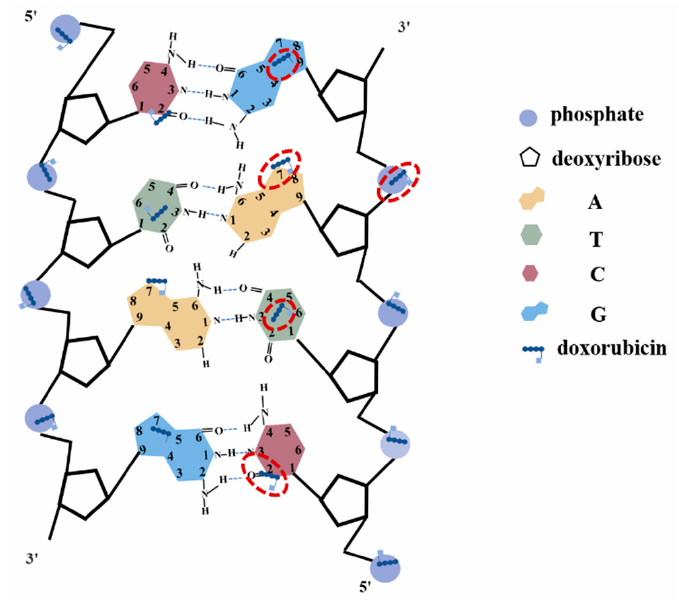
Figure 7. The diagram of the interaction sites of DOX and DNA.